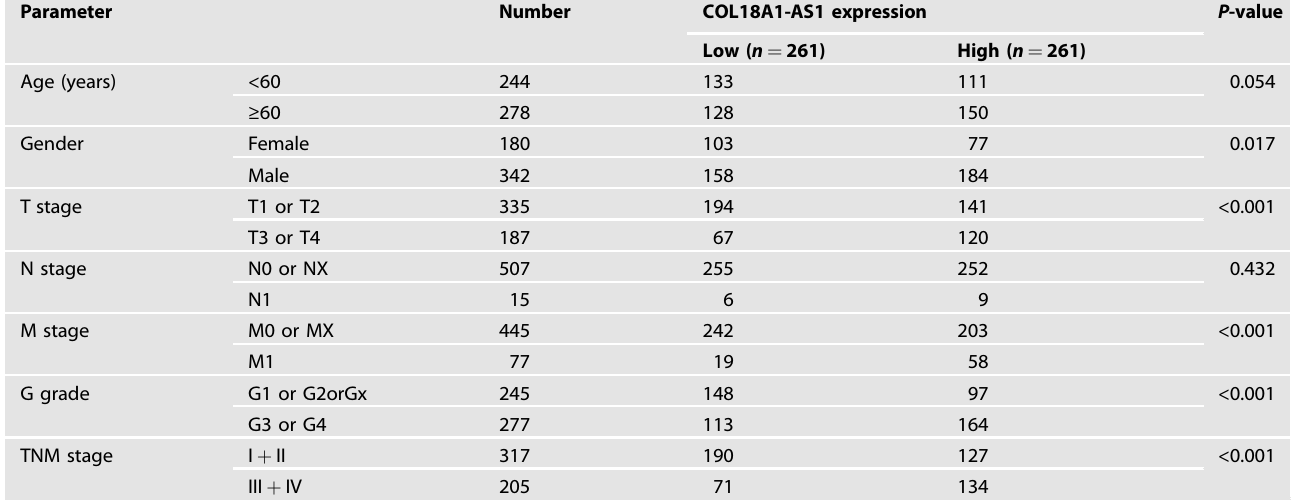
Table 1. Correlation between COL18A1-AS1 expression and clinicopathological parameters of ccRCC patients.